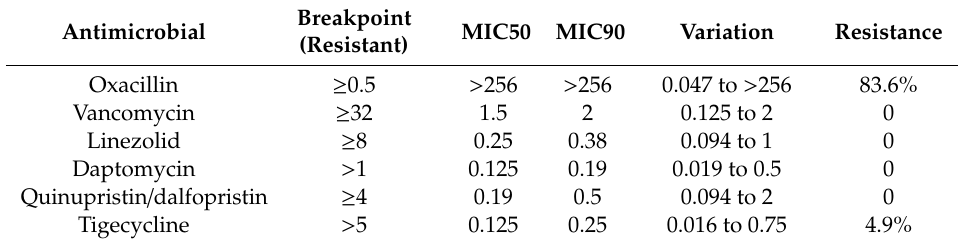
Table 4. Minimum inhibitory concentration (MIC) of antimicrobials (mg / mL), range of MIC (mg / mL), and percentage of resistant CoNS. Breakpoint MIC50 MIC90 Variation Resistance Antimicrobial (Resistant) Oxacillin ≥ 0.5 > 256 > 256 0.047 to > 256 83.6% Vancomycin ≥ 32 1.5 2 0.125 to 2 0 Linezolid ≥ 8 0.25 0.38 0.094 to 1 0 Daptomycin > 1 0.125 0.19 0.019 to 0.5 0 Quinupristin / dalfopristin ≥ 4 0.19 0.5 0.094 to 2 0 Tigecycline > 5 0.125 0.25 0.016 to 0.75